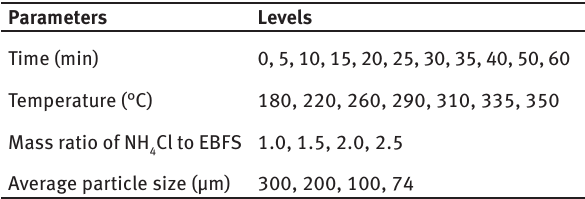
Table 1: Design of the experiment.